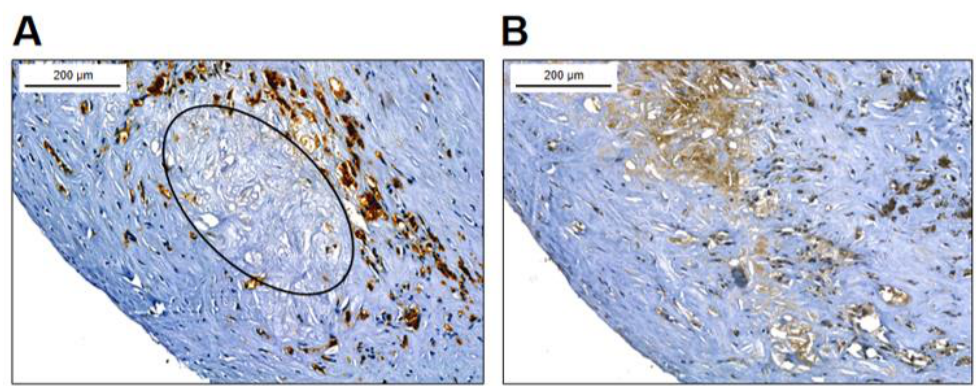
Figure 3. Macrophages in carotid artery plaque. ( A ) Type IV carotid artery plaque, with clearly visible lipid core, most of which is within the elliptical border. The lipid core is surrounded by CD68-positive macrophages. ( B ) FXIII-A-positive cells are detected in the plaque by immune-peroxidase staining; FXIII-A is also present extracellularly in the lipid core. More details are shown in Figure